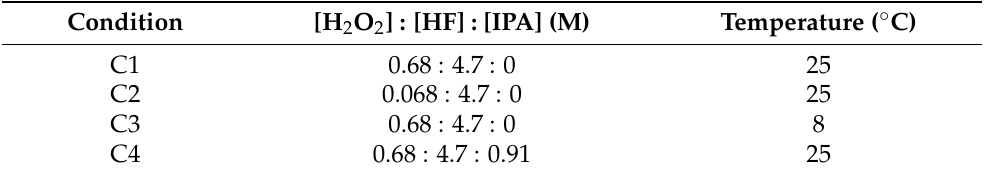
Table 1. Investigated MACE